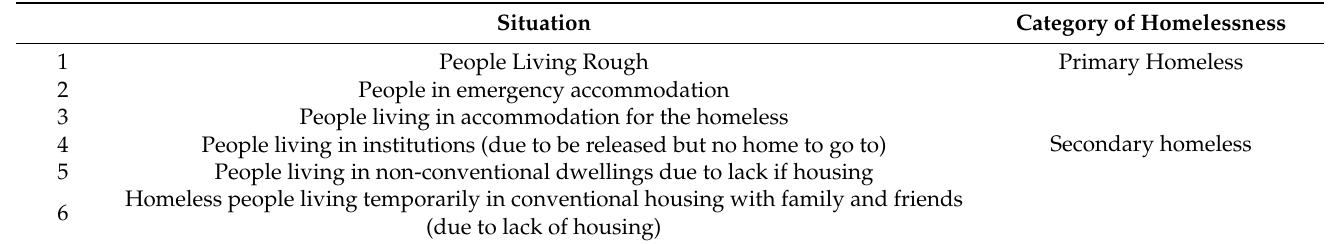
Table 1. Definitions and measuring homelessness